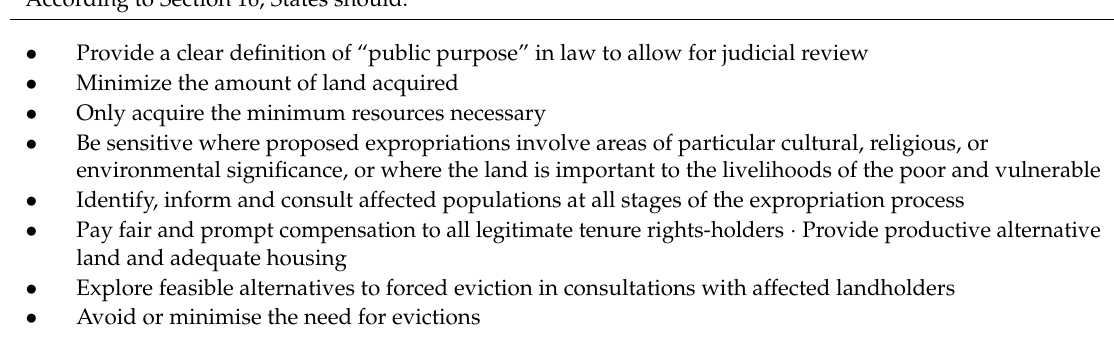
Table 1. Highlights from the